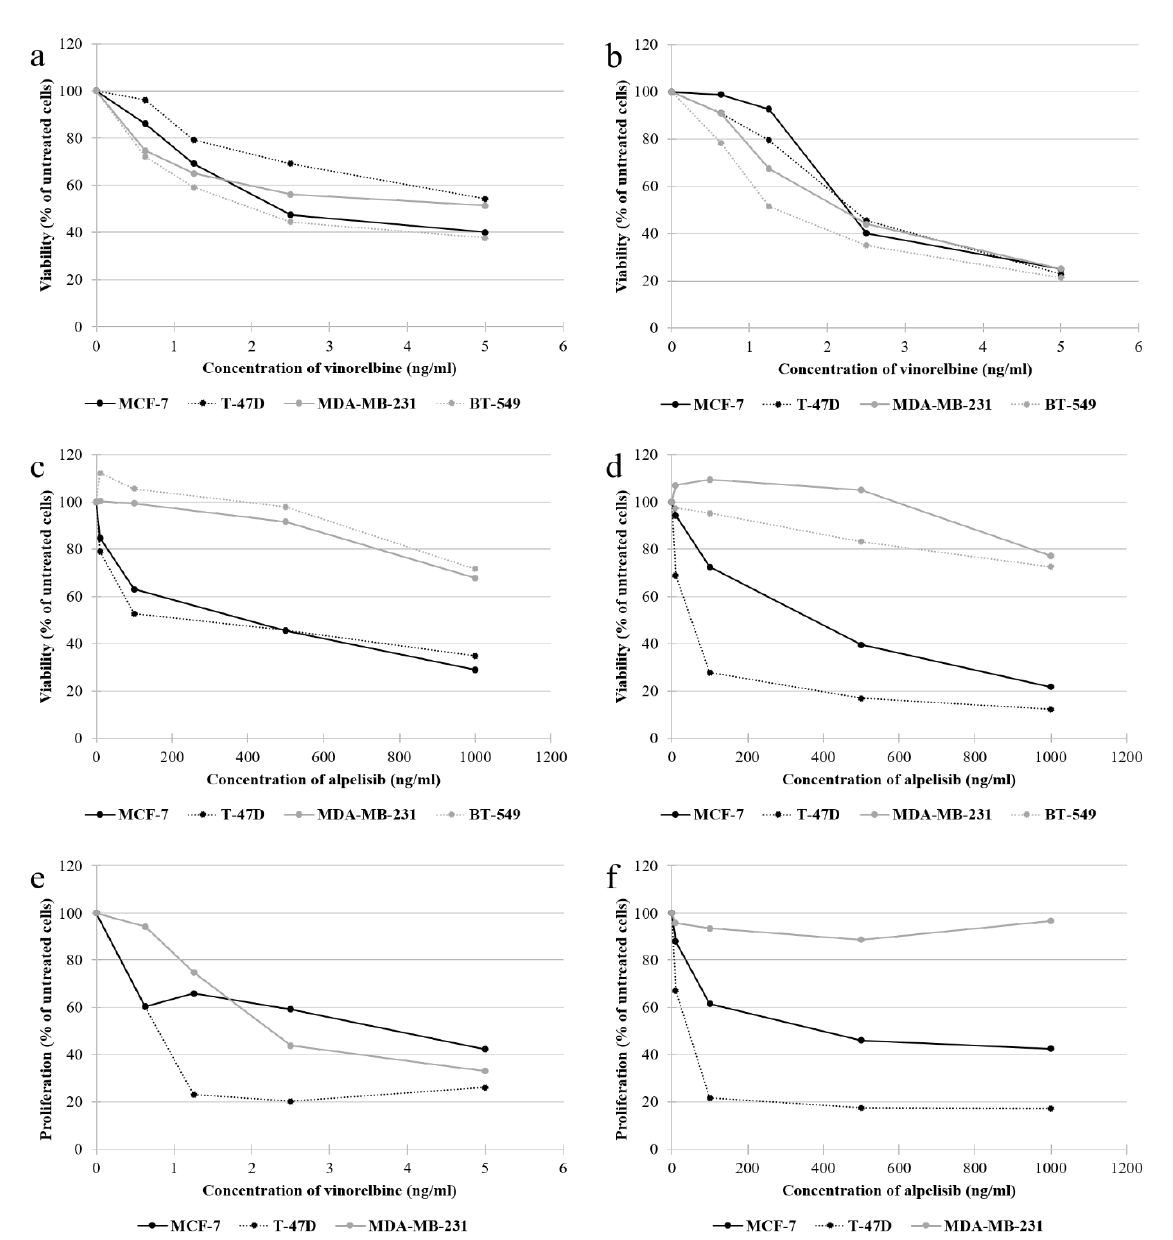
Figure 4: Dose-response curves of vinorelbine and alpelisib regarding cell viability: vinorelbine ( a , b ), alpelisib ( c , d ) after 3 and 7 days of treatment and regarding cell proliferation: vinorelbine ( e ), alpelisib ( f ) after 7 days of treatment. The results are shown as the mean of three separate experiments. The standard deviation results are shown in Figure 1 and Figure 3, respectively, and have been omitted from this figure for